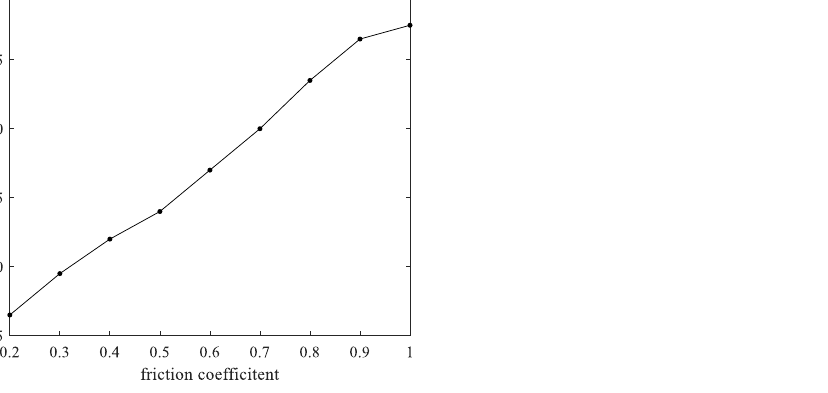
Figure 11. Convergence curve of the inclination angle and friction coefficient at A = 5 mm, a = 90 ◦ , and f = 16